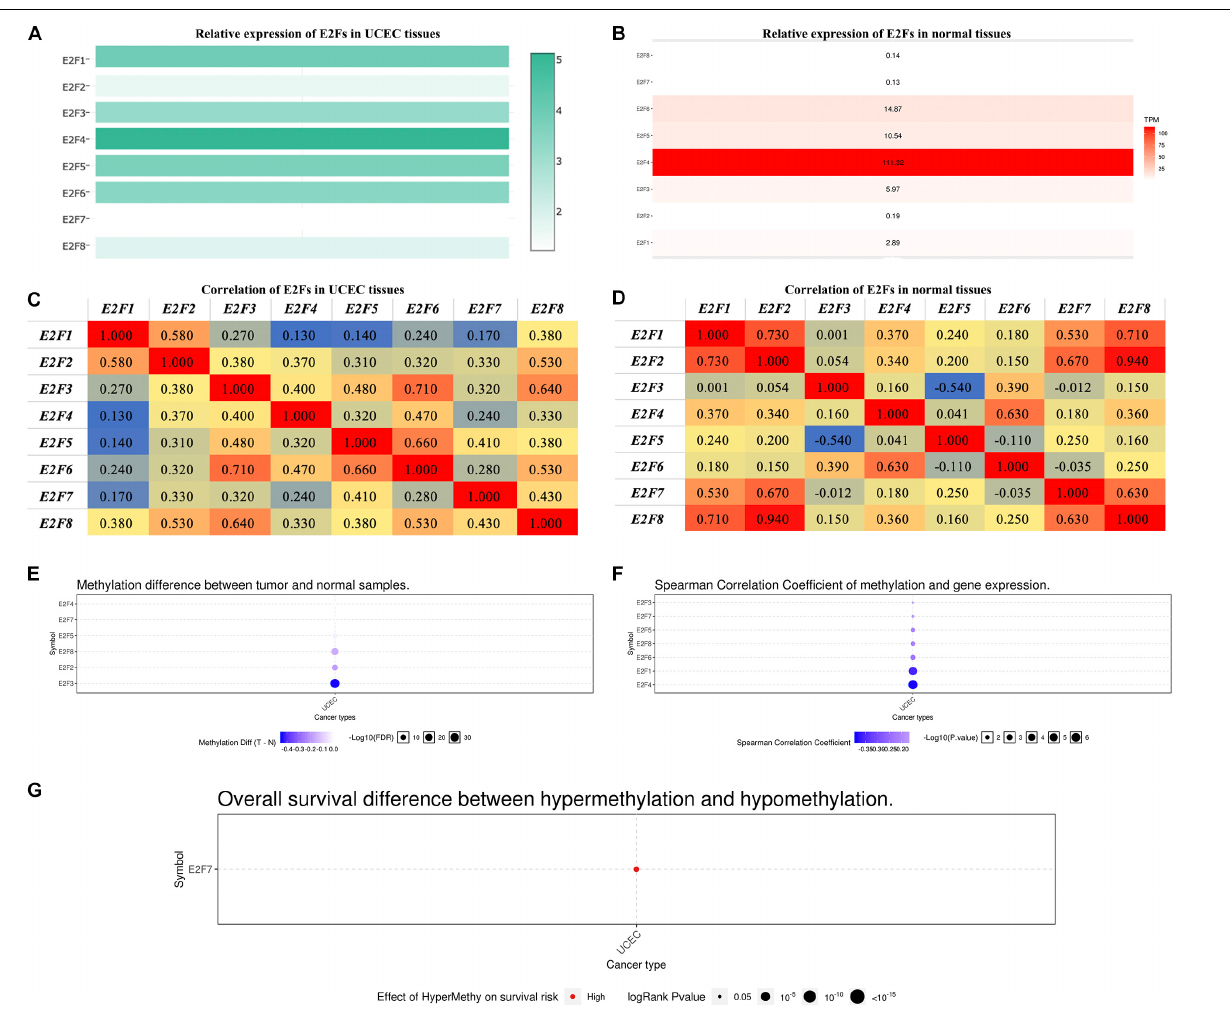
FIGURE 3 | The expression of E2Fs in normal and UCEC. (A) The relative expression of E2Fs in UCEC tissues and (B) normal tissues. (C) Correlation between each E2F member and UCEC and (D) normal tissues. (E) Differences in the methylation of E2Fs in UCEC and normal tissues. (F) Correlation between methylation of E2Fs and their corresponding expression in UCEC. (G) The role of methylated E2F7 in the survival of UCEC